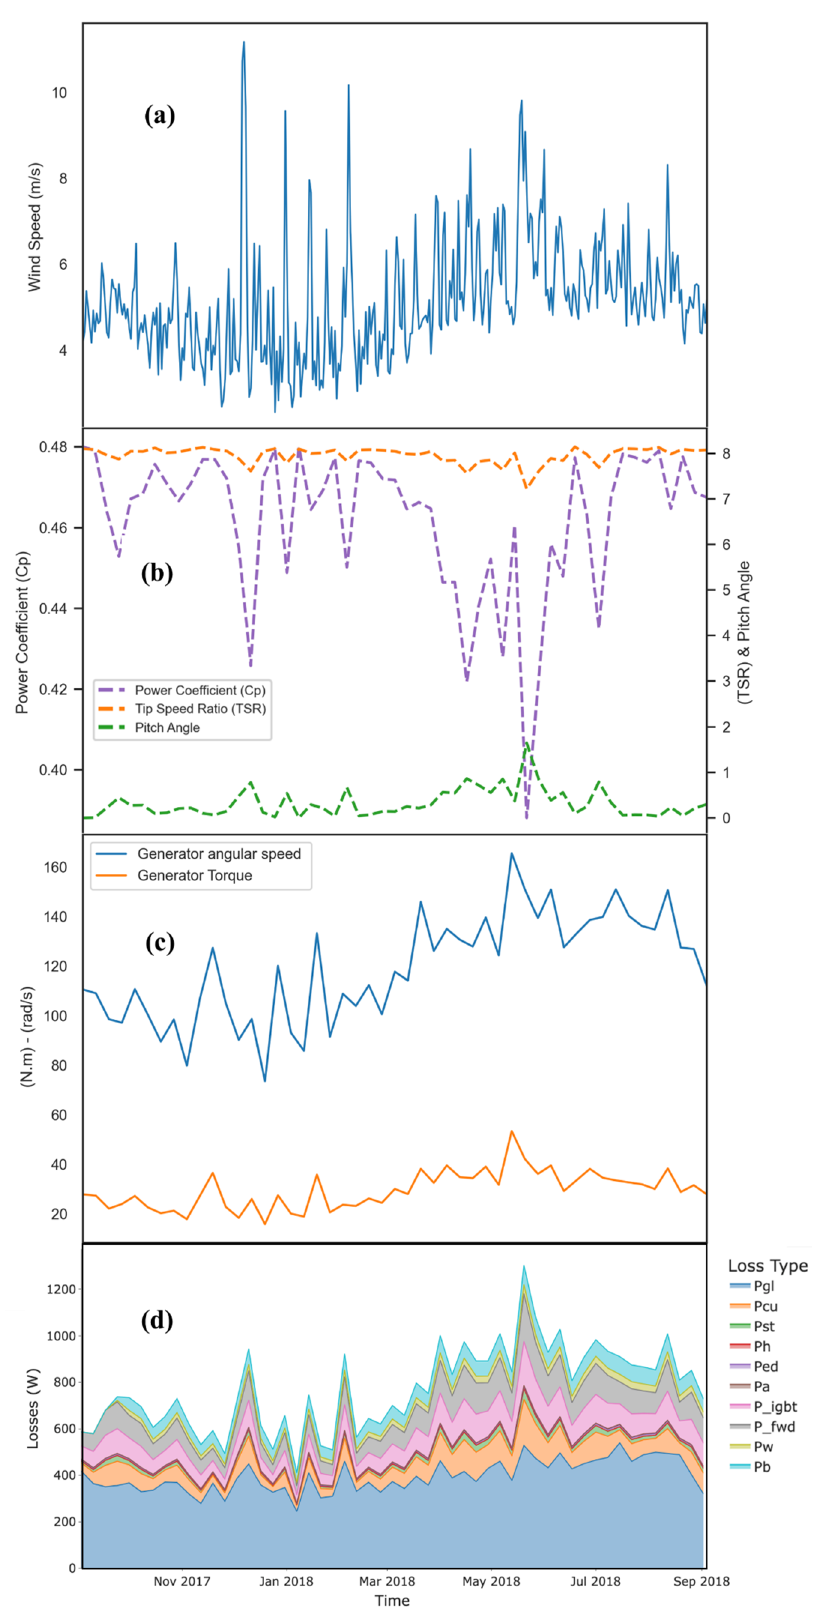
Figure 10. Model results for a 20 kW indirect drive wind turbine installed in Gwadar city: ( a ) wind speed, ( b ) behavior of decision variables, ( c ) generator torque and angular speed, and ( d ) power losses .